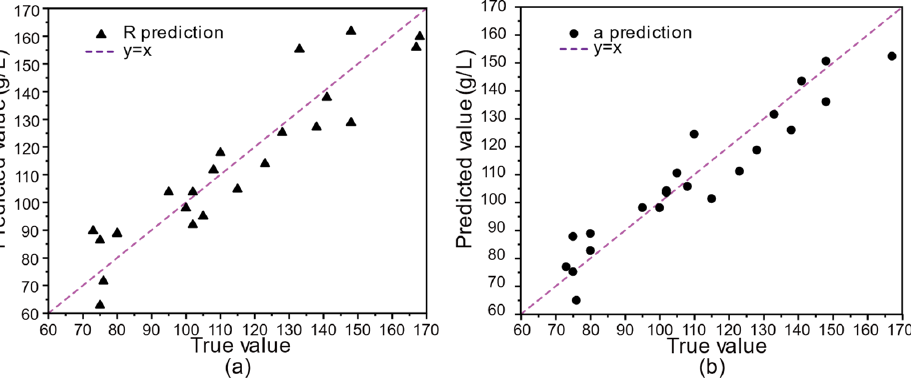
Figure 7. Prediction results of hemoglobin concentration using: ( a ) “R” channel and ( b ) “a” channel.